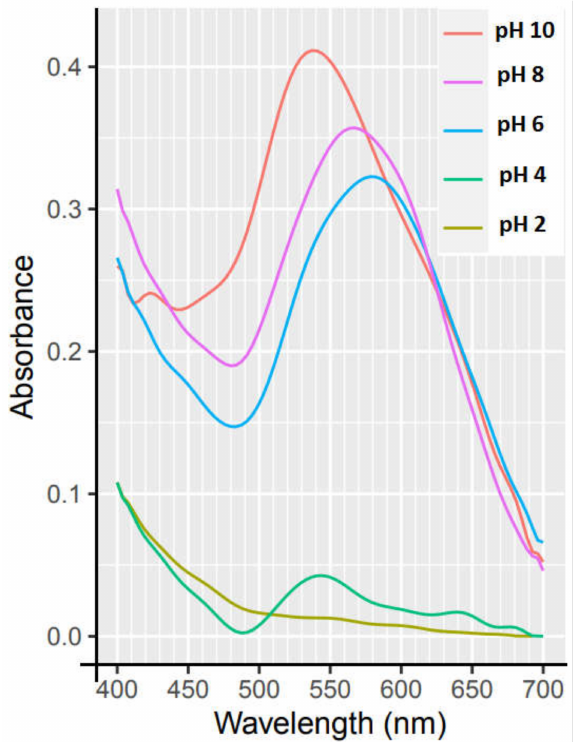
Figure 2. Visible spectra of five samples with different pH values (pH values were adjusted before the preparation of AuNPs). The samples were diluted 1:2 with ddH 2